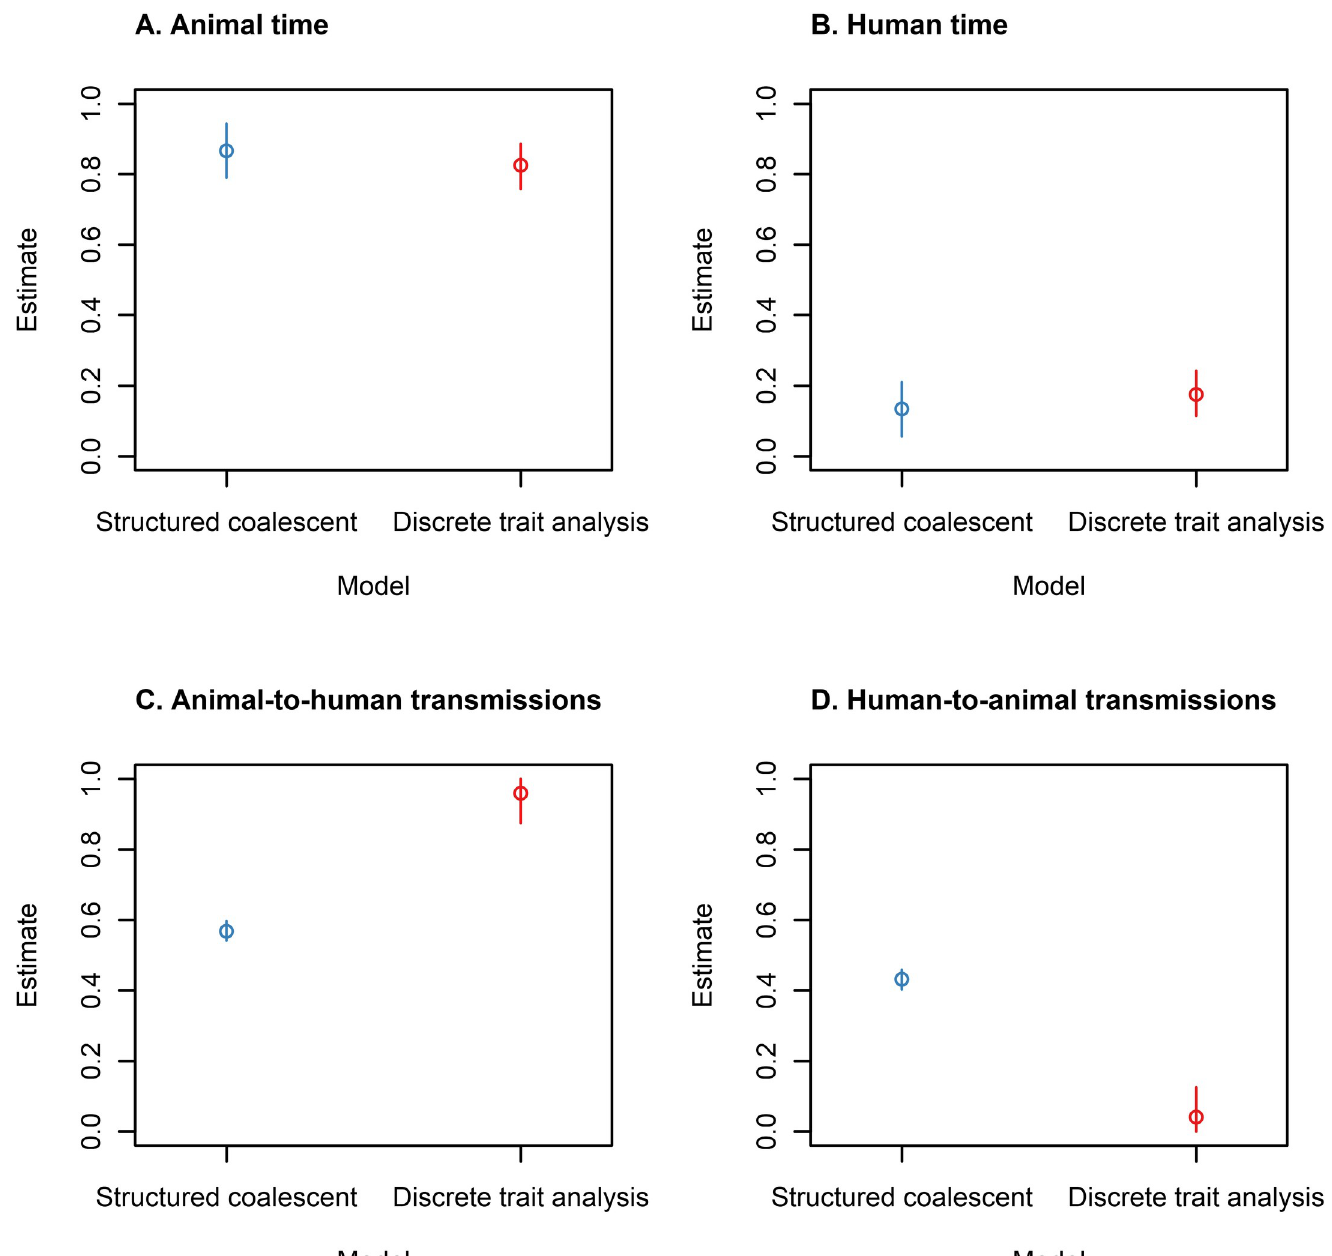
Fig 17. Estimates of the proportion of time spend in the animal (A) and human (B) host populations, and the proportion of inter-population transmissions made up of animal-to-human (C) and human-to-animal (D) transmissions for the DT160 outbreak, as estimated by the SC (blue) and DTA (red) models on 109 isolates. The circles represent the mean and the error bars represent the 95% HPD